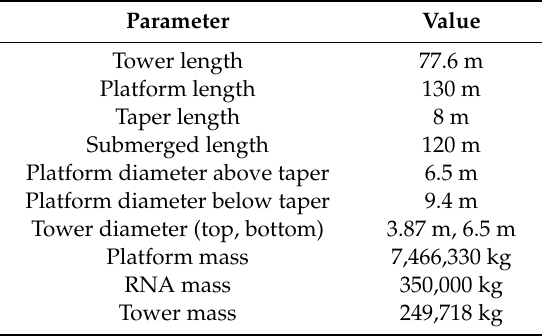
Table 1. Structural parameters of